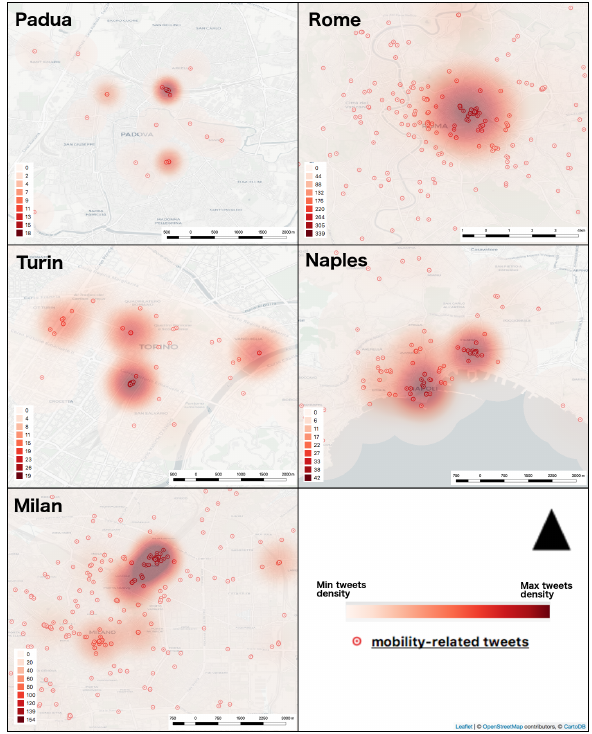
Figure 3. Heatmaps computed from mobility-related tweets for 5 city